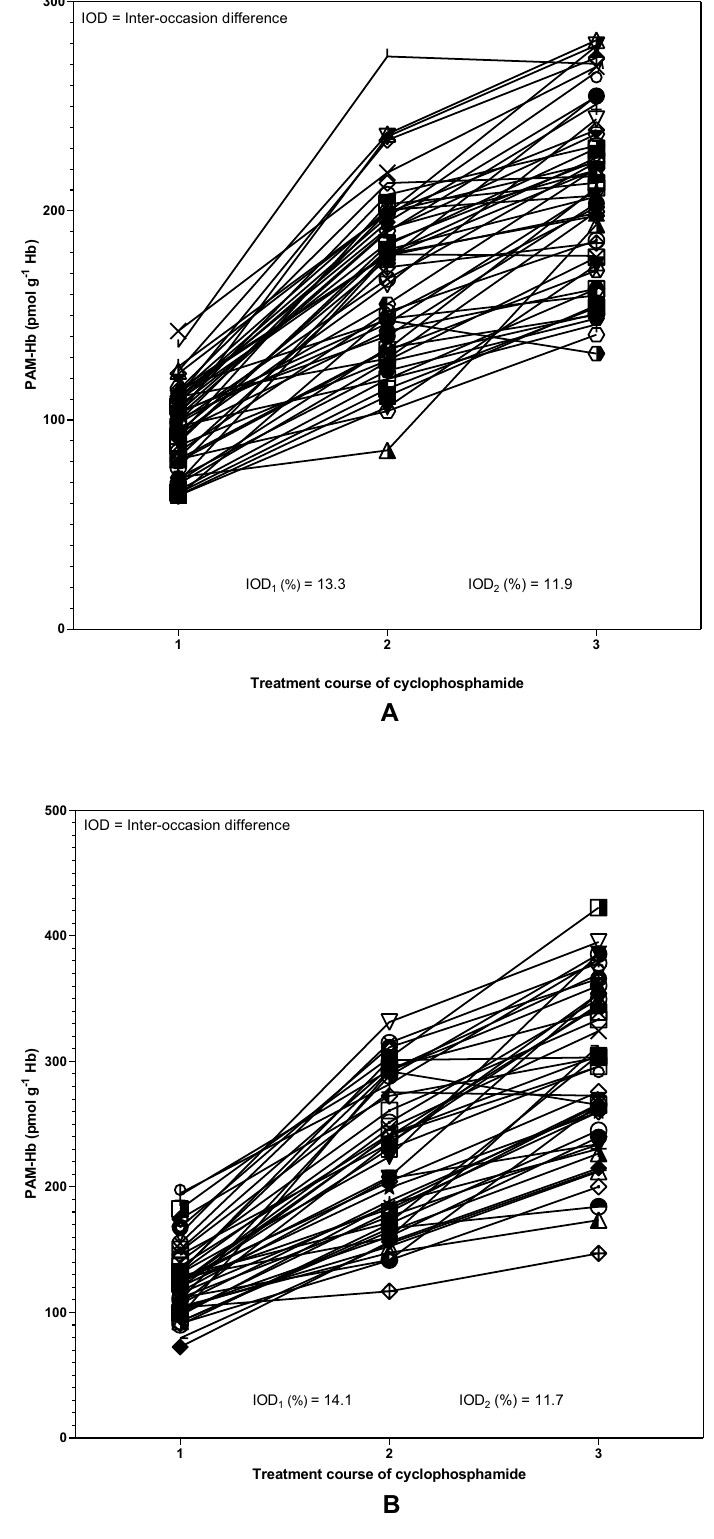
Figure 3. Phosphoramide mustard-hemoglobin (PAM-Hb) levels of 51 patients receiving 500 mg cyclophosphamide (C500 group) per body surface area unit ( A ) and 46 breast cancer patients receiving 600 mg cyclophosphamide (C600 group) per body surface area unit ( B ) and the mean inter-occasion difference (%) between treatment courses of